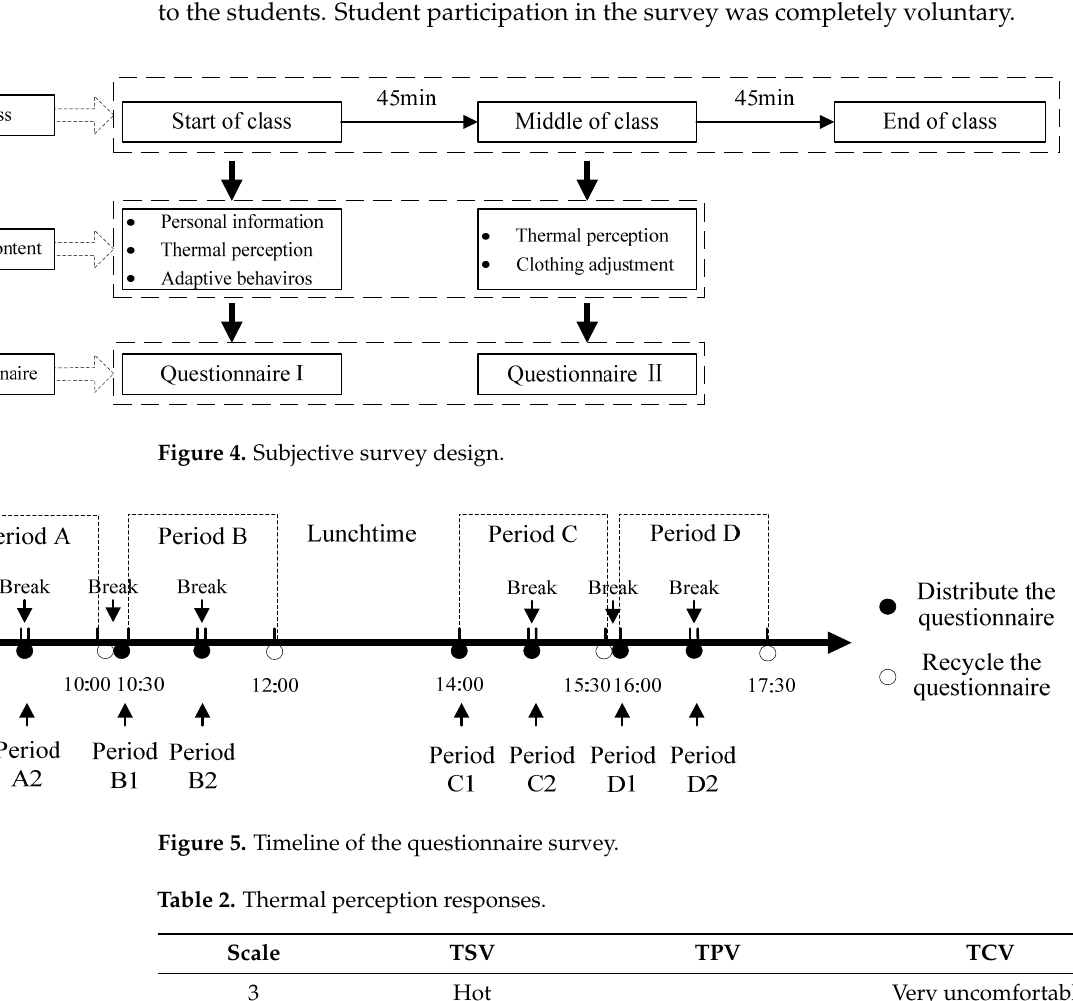
Table 2. Thermal perception responses.